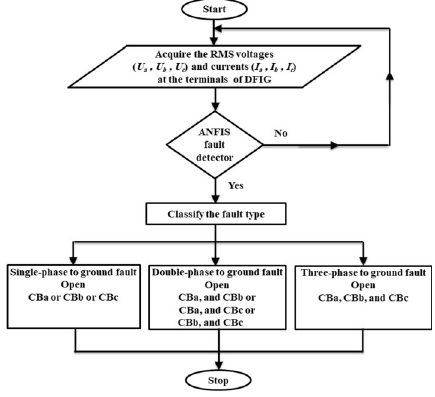
Fig. 7 Flowchart of proposed CBFT protection technique using ANFIS networks